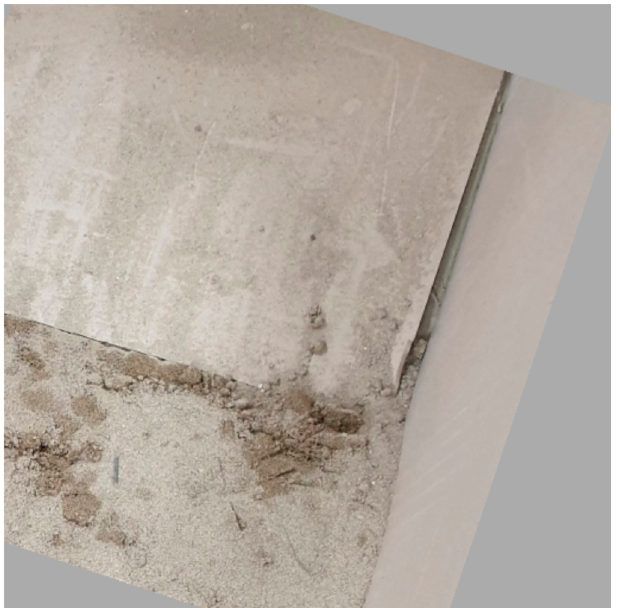
Figure 8. Photo generated through a 45° random rotation for data augmentation, during training.